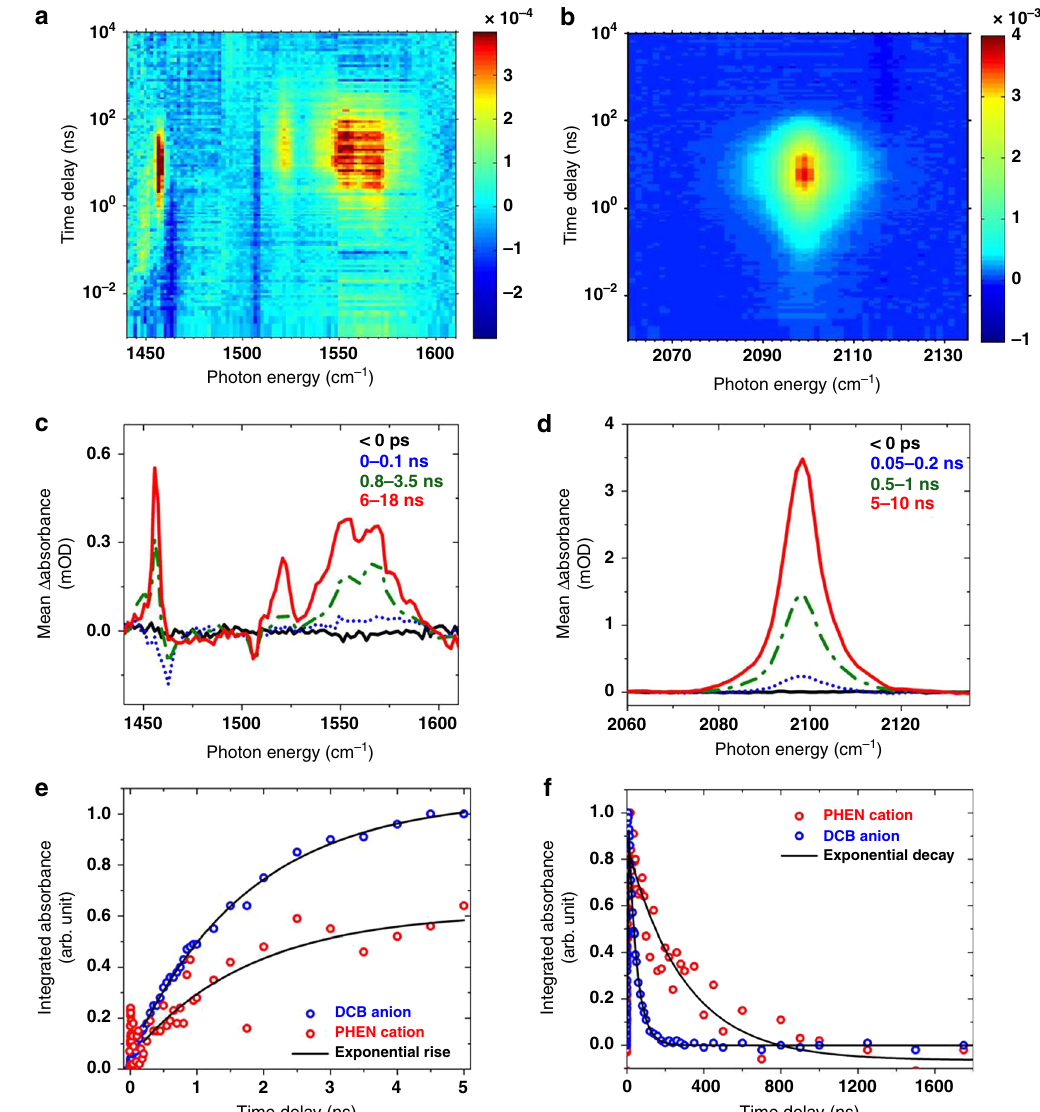
Fig. 2 Single electron transfer from PHEN* to DCB. a , b 2D false color maps of the time-resolved infrared (TRIR, or transient infrared) spectra of a mixture of PHEN (~8 mM) and DCB (~30 mM) in acetonitrile-d 3 which is photoexcited at 256 nm. Note the logarithmic scale of the time axis. Amplitude units are in differential optical density ( Δ OD), as annotated by the color bar on the right. c , d TRIR spectra in the top panels are shown as evolving over representative time windows (solid black line measured at negative time delays is a reference for the baseline; dotted blue line is for 0 – 100 ps in c and 50 – 200 ps in d ; dash-dotted green line is for 0.8 – 3.5 ns in c and 0.5 – 1 ns in d ; solid red line denotes 6 – 18 ns in c and 5 – 10 ns in d ). The decay of the peaks on longer timescales, evident in the top panel, is not shown here for clarity. e Rise in the integrated absorbance of the peaks between 1520 and 1580cm − 1 (hollow red circles, PHEN + ) and 2098 cm − 1 (hollow blue circles, DCB − ) is fi t to a global single-exponential time constant of 1.7 ± 0.1 ns. Note that the overlapping peaks due to PHEN* have weaker absorption and do not dominate the kinetics beyond 100 ps. f Decay in the integrated absorbance of the same peaks shows different exponential decay time constants for DCB − (42 ± 1 ns) and PHEN + (300 ± 30 using a 100 mM stock solution in order to measure the pseudo fi rst-order electron transfer rate coef fi cient. The dataset shown in Fig. 2 represents the highest concentration of DCB at which the reaction is probed and is chosen for the best signal-to-noise ratio.